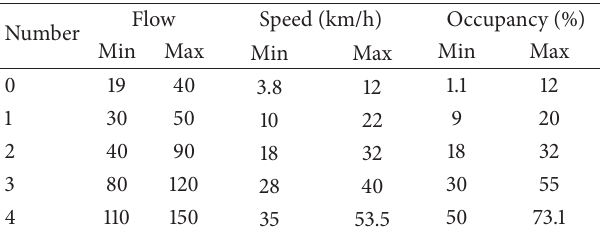
Table 5: Threshold value of qualitative concept.